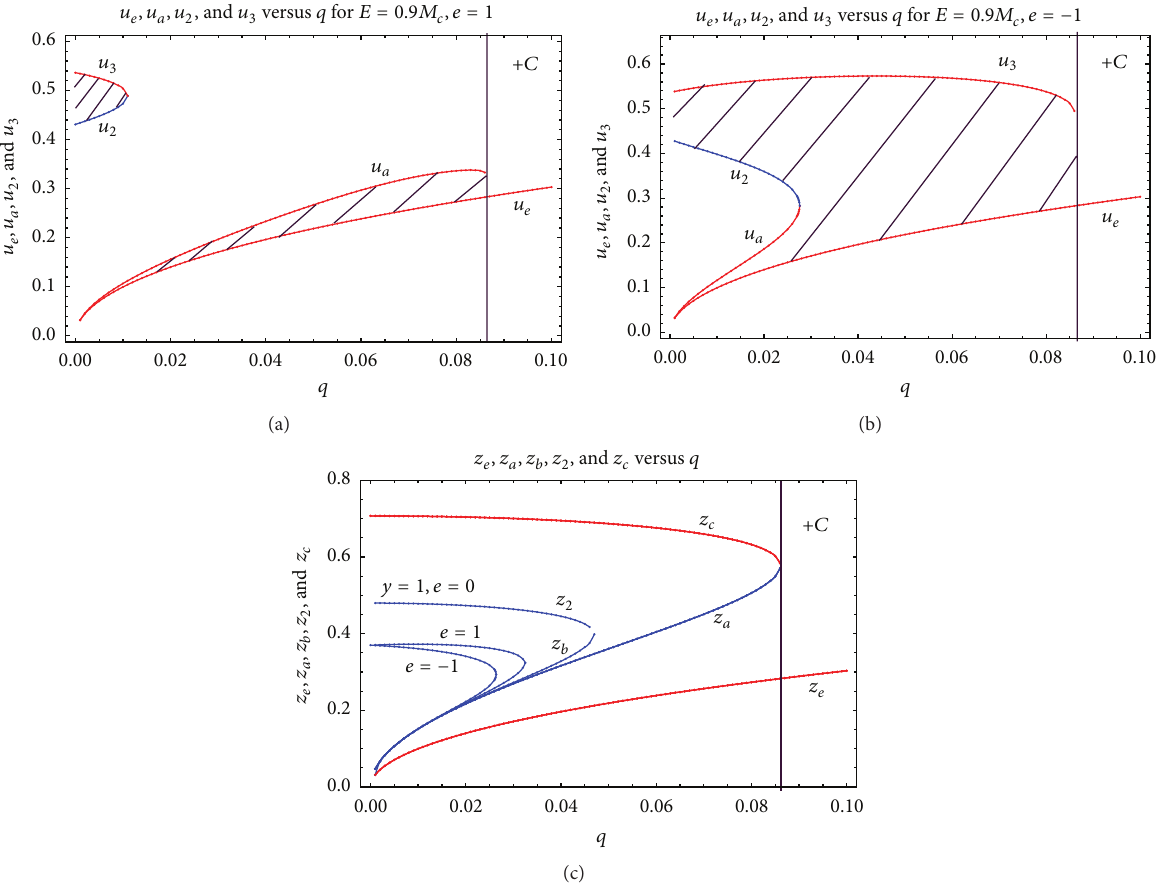
Figure 10: Allowed region of the mixed phase for AdS 5 from the energy constraint 𝐸 < 0.9𝑀 𝑐 for radiation with positive ( 𝑒 = 1 ) (a) and negative ( 𝑒 = −1 ) (b) charge, respectively. The allowed region from the heat capacity condition 𝑆 󸀠󸀠 (𝐸 𝑟 ) < 0 is the region between the lines 𝑧 𝑧 𝑧 𝑧 𝑎 - 𝑐 and 𝑏 - 2 shown in (c) where the results of all charges in order to compare with the zero-charge ( 𝑒 = 0 ) case with 𝑔 𝑏 = 𝑔 𝑓 = 2